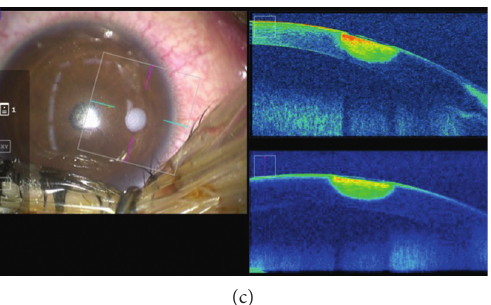
Figure 5: MIOCTimages in cases of corneal trauma. (a) MIOCTimage of a plant thorn piercing the deep cornea. Preoperative examination revealed that the DM near the plant thorn protruded (arrow), which was suggestive of corneal perforation. (b) MIOCT image immediately after removal of the plant thorn. No high-intensity shadow suggestive of residual foreign bodies in the cornea was found. (c) MIOCTimage of a partial alkali burn in the cornea. The opacity was found to spread approximately to three-quarters of the corneal depth. If there is a delay between outpatient clinic examination and emergency surgery, the depth of the cornea opacity can be checked again to determine if the effect of alkali has progressed since the initial